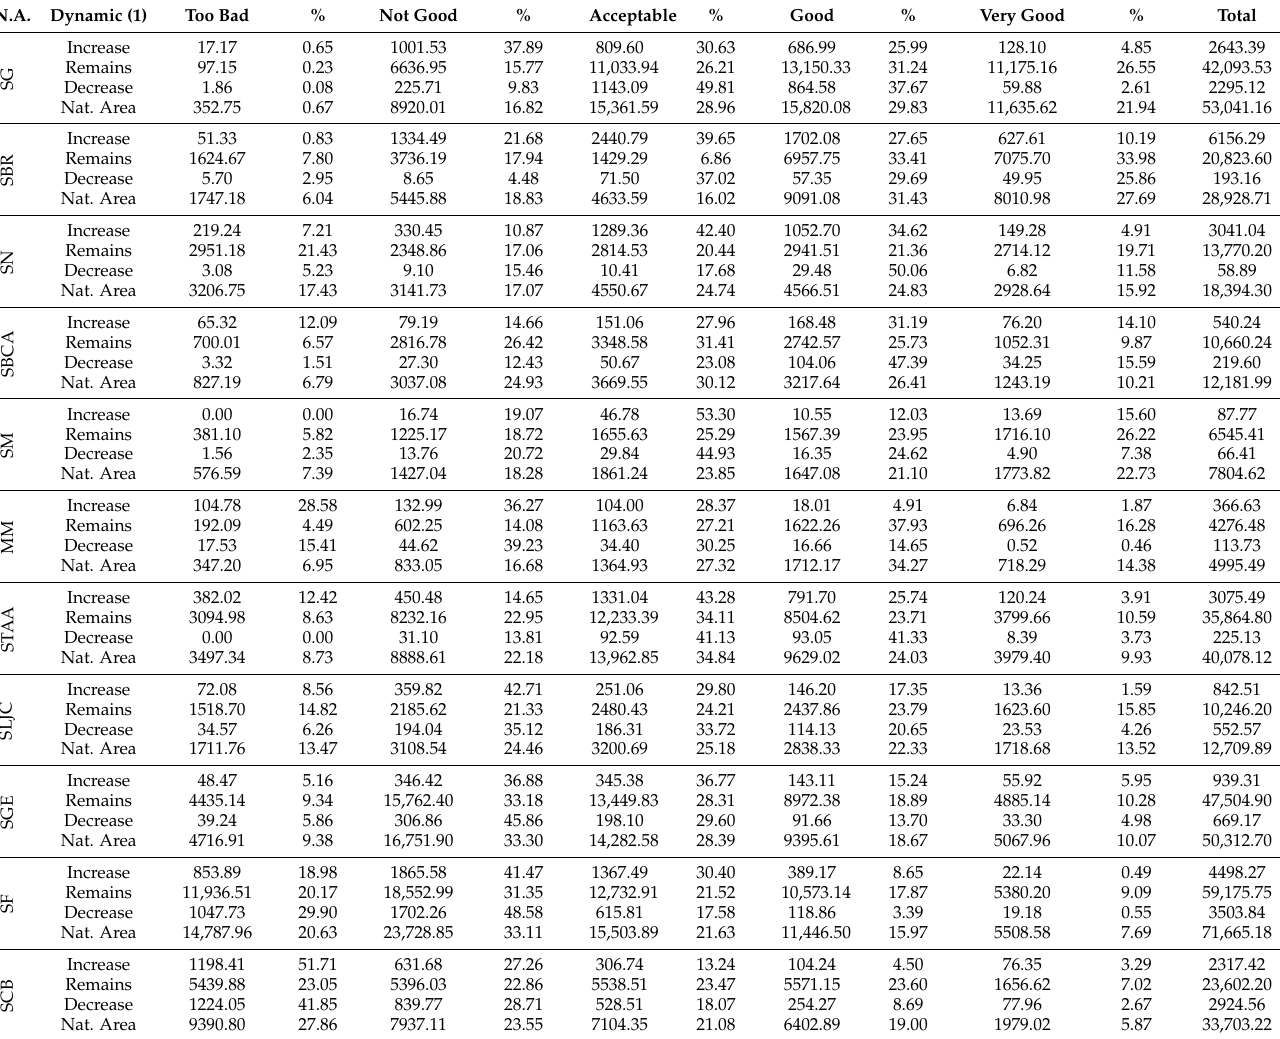
Table 11. Dynamics of change (1991–2021) and assessment of conservation status according to vegetation indices (NDVI, NDWI, and EVI) of forest areas and areas of shrub and herbaceous vegetation uses. Area in